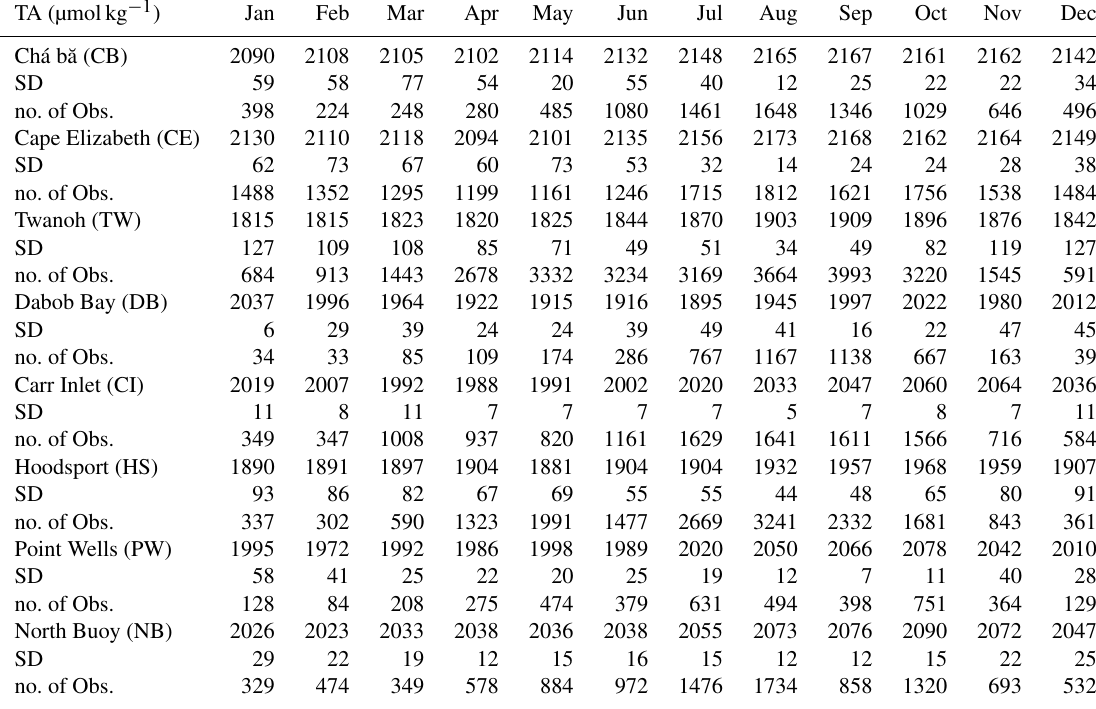
Table C3. Average monthly TA seasonal cycles for the eight Washington State moorings with appropriate SSS observations (vast majority of SSS >20) to estimate TA. The average monthly standard deviation (SD) and total number of observations (no. of Obs.) contributing to the monthly average estimate are included.